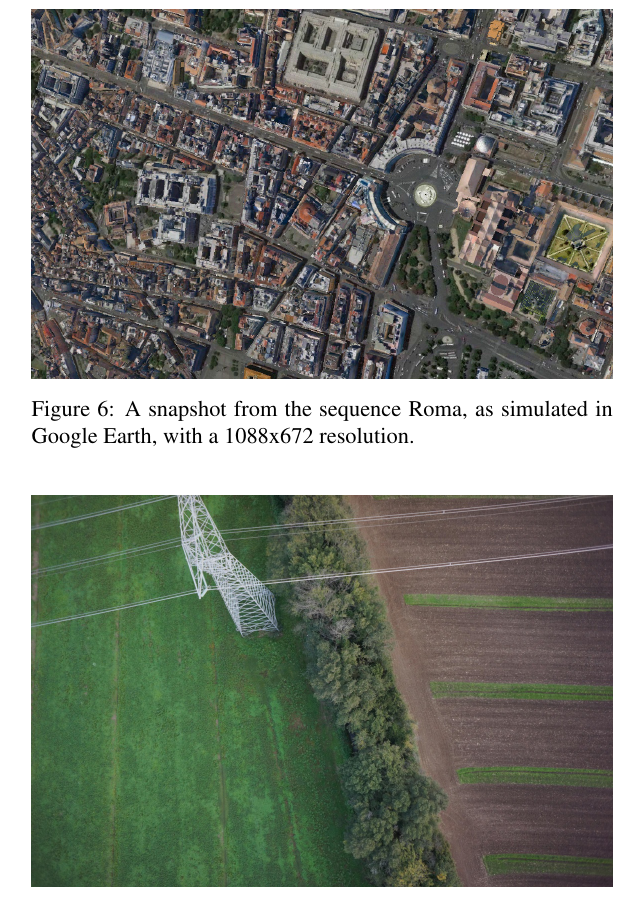
Figure 7: A snapshot from the sequence Brezza, with a 3000x2000 resolution.